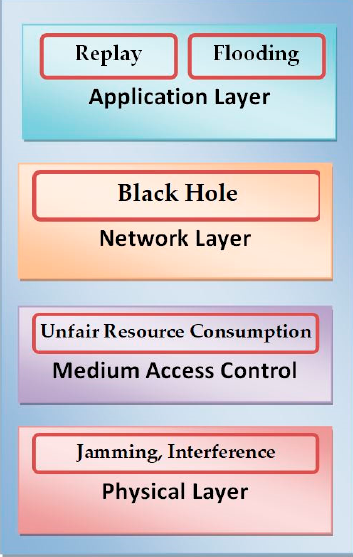
Figure 2. Denial of Service (DoS) attacks at the OSI layers of Zigbee protocol.